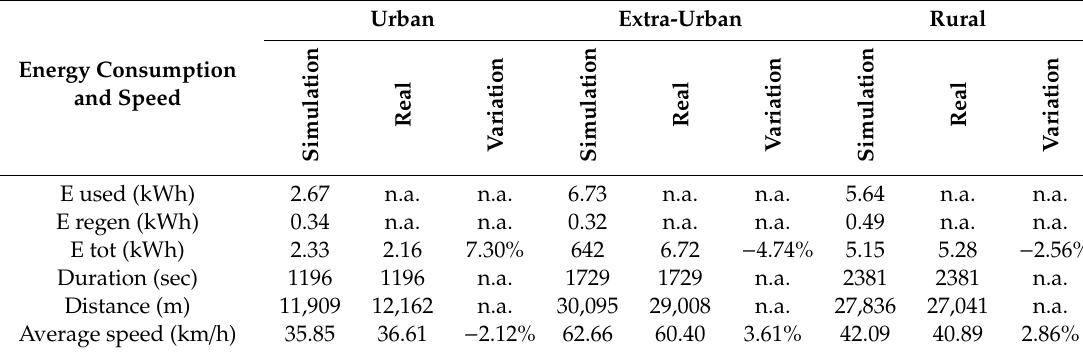
Table 6. Energy, distance and